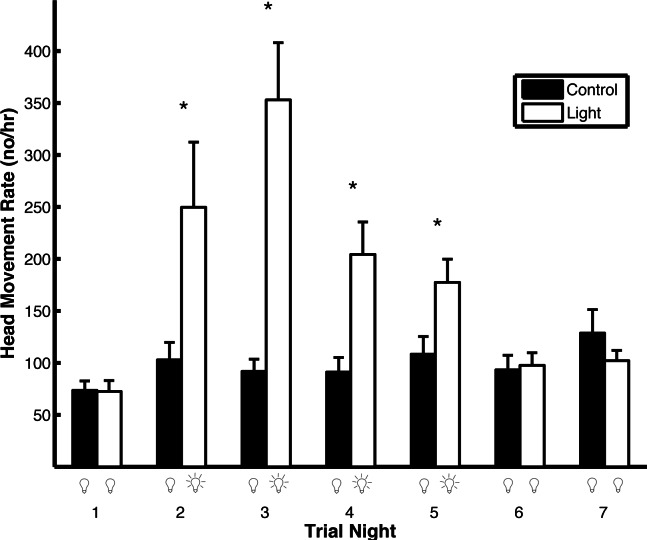
Artificial light pollution increases head movement rates (means ± SE).Head movement rates were similar on nights when the artificial light was off in both light and control trials (nights 1, 6, and 7). Head movement rates were significantly higher during nights when the artificial light was on during the light trials and off during the control trials (nights 2–5). Asterisks indicate significant differences in head movement rates between the light and control trials.